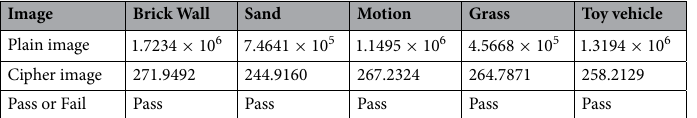
Table 6. The χ 2 test results.